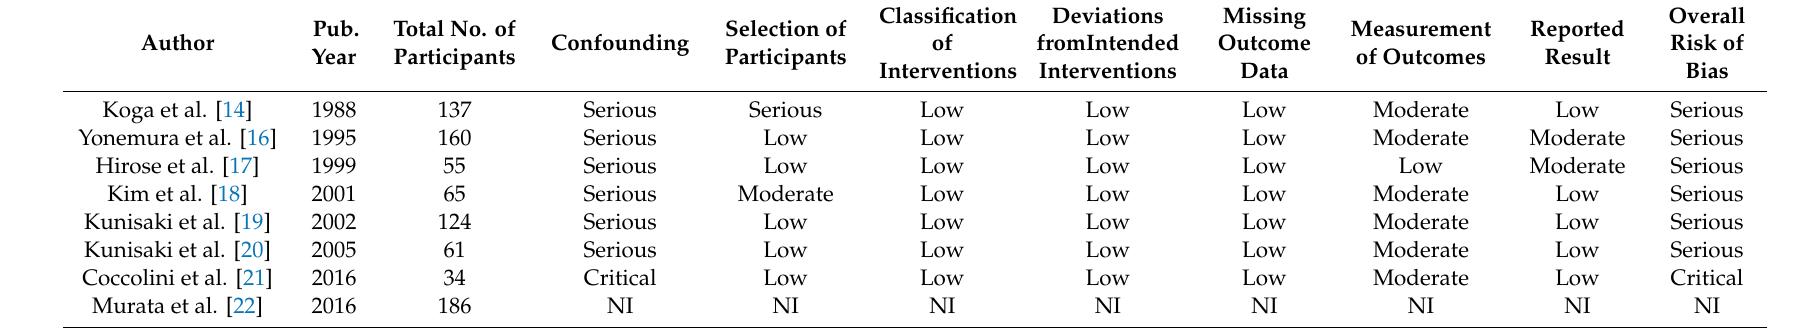
Table 2. Risk of bias of non-randomised comparative